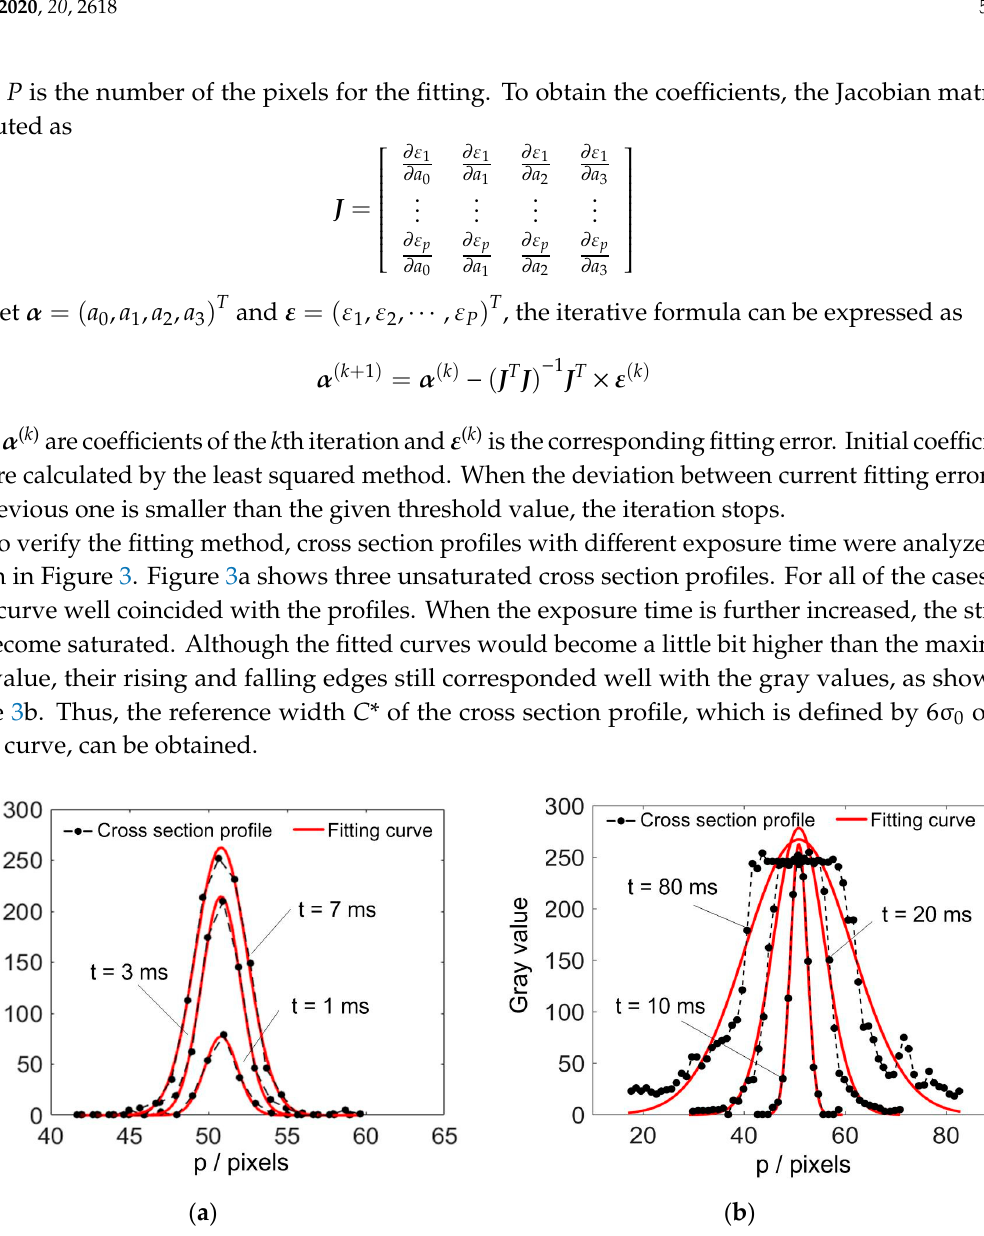
Figure 3. Stripe cross section profiles with different exposure time and the corresponding Gaussian fitting (GF) curves. ( a ) Unsaturated profiles, ( b ) Saturated profiles.